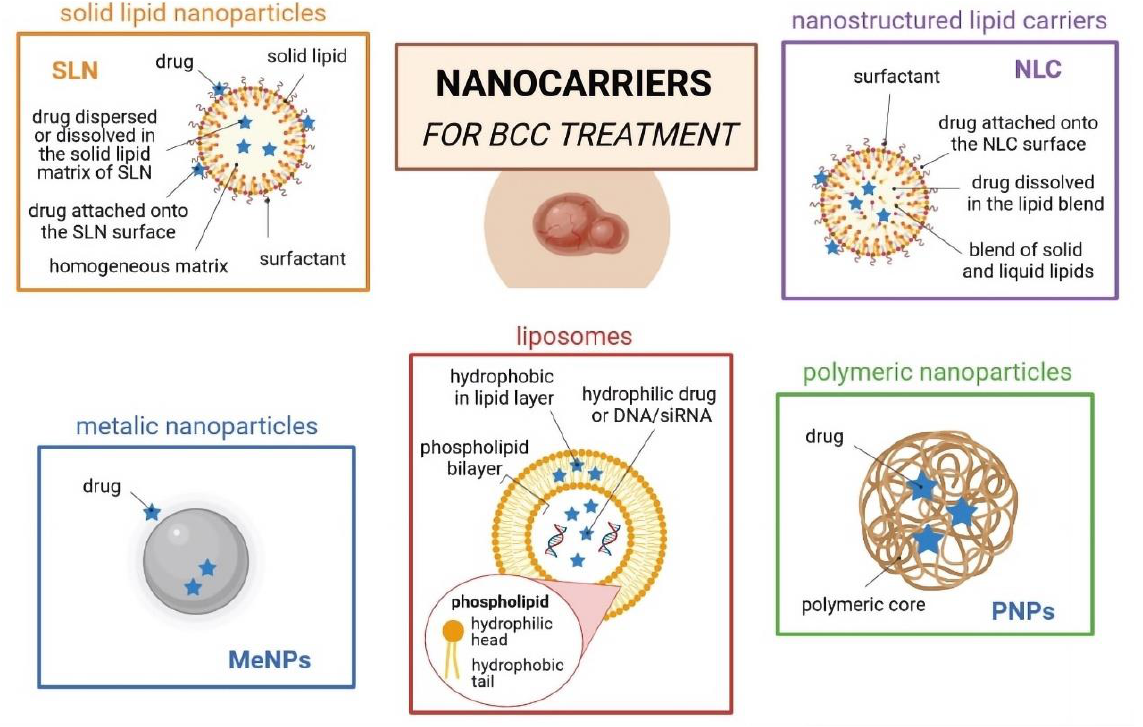
Figure 2. Schematic characterization of the most commonly used nanoparticles for BCC treatment, namely solid lipid nanoparticles (SLNs), nanostructured lipid carriers (NLCs), metal-based nanoparticles, liposomes, and polymeric nanoparticles (own drawing).